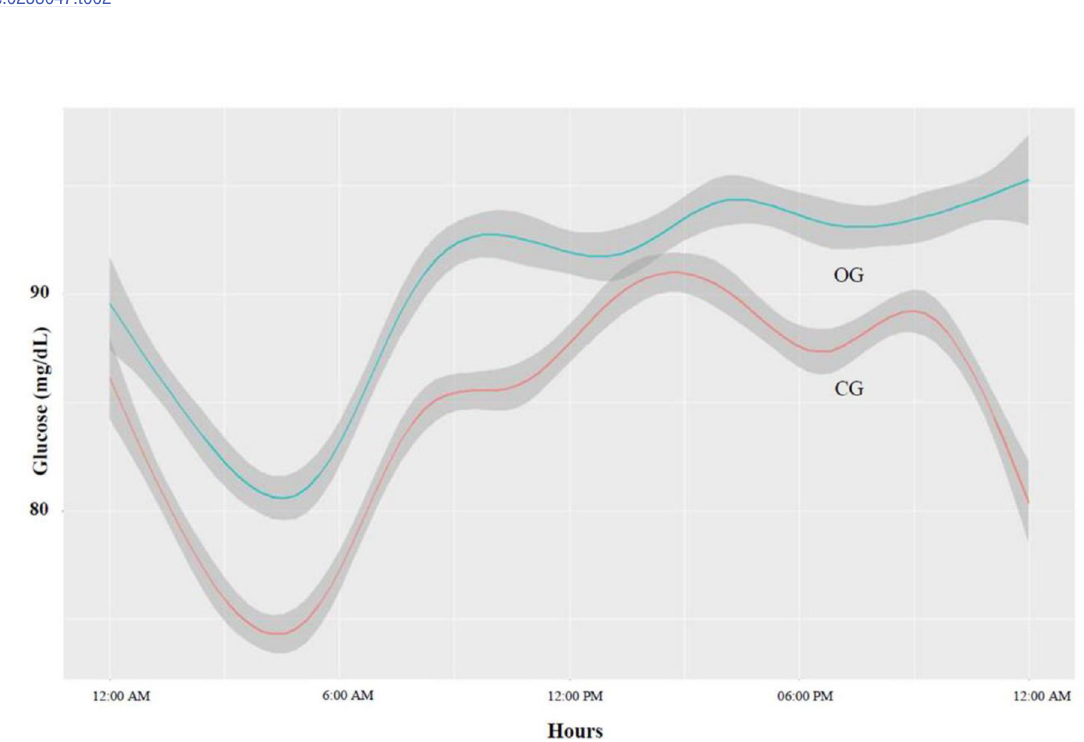
Fig 1. Glucose profile during 24 hours in the obese and control group. Obese group (OG) is represented by the green smooth curve (lambda = 1,000,000) and control group (CG) by the red smooth